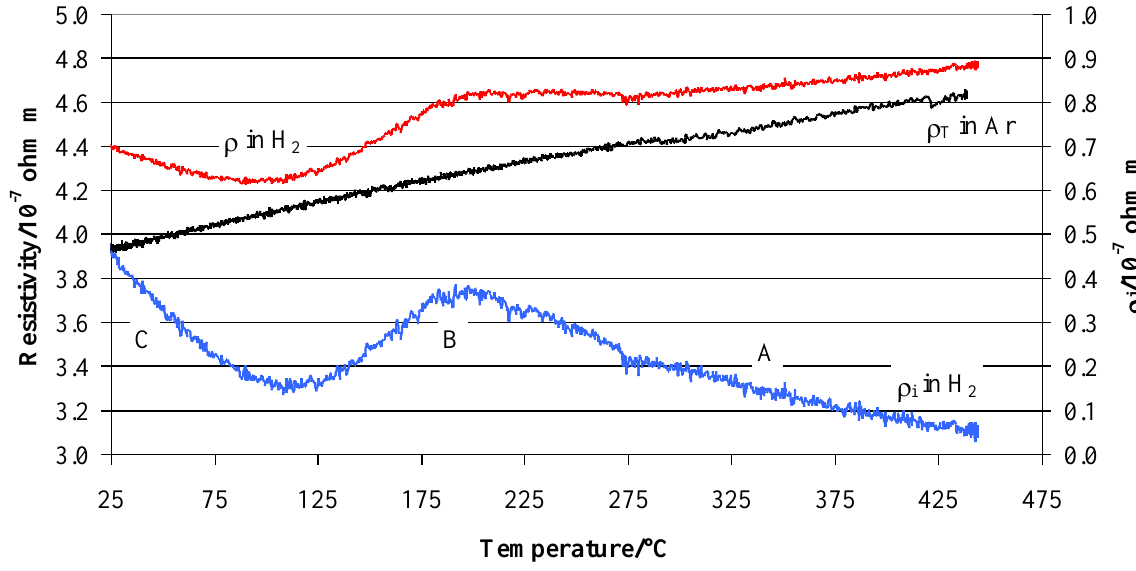
Figure 3. Total resistivity ( ρ ), contribution due to the scattering measured in pure hydrogen ( ρ i ), and contribution of ρ T measured in argon of Pd–Ag 21 wt. % thin foil. For all temperatures, the measurements were performed at 100 kPa of hydrogen.